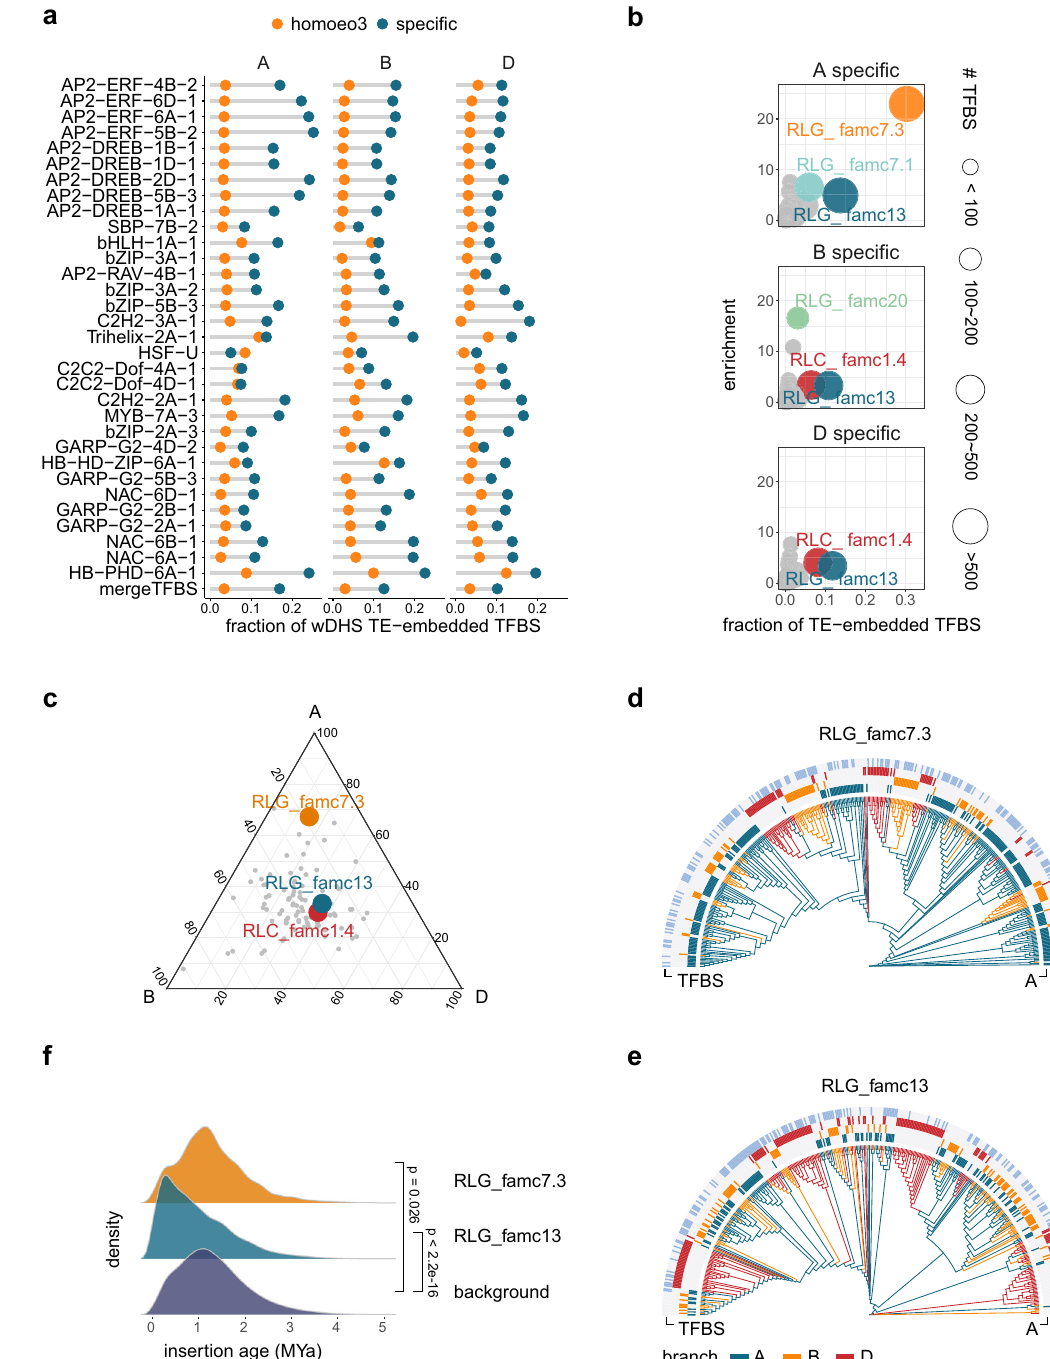
Fig. 4 | Speci fi c TE families contribute to subgenome-speci fi c TFBS expansion. a Fraction of subgenome-homoeologous and -speci fi c TFBSs embedded in TEs within open chromatin regions characterizedby DHS. The TFs with more than100 subgenome-homoeologous and -speci fi c TFBSs within the DHS are presented. b Enriched TE subfamilies harboring subgenome-speci fi c TFBSs, with the fraction of each TE subfamily across the genome as the background. c Relative abundance of TE subfamilies across subgenomes. The most enriched TEs in Fig. 4b are high- lighted. d , Dendrogram presenting the sequence similarity of the full-length